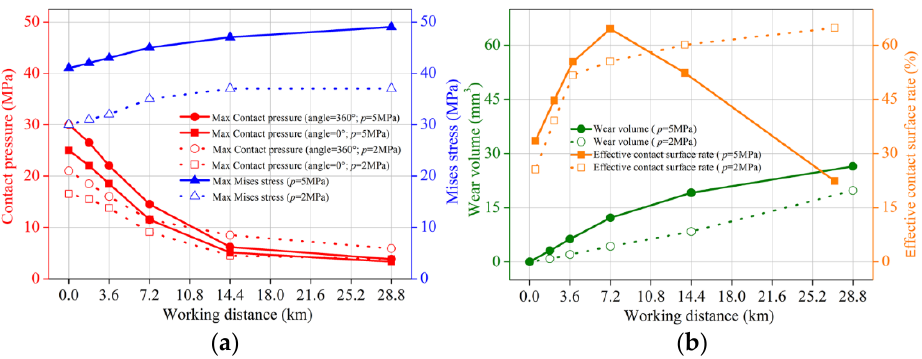
Figure 17. ( a ) Maximum contact pressure and maximum mises stress; ( b ) Wear volume and effective contact surface rate of C-ring under different gas pressure. contact surface rate of C-ring under different gas pressure.